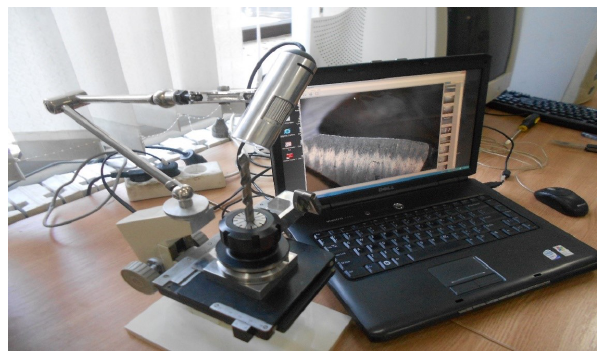
Figure 15. DigiMicro 2.0 microscope